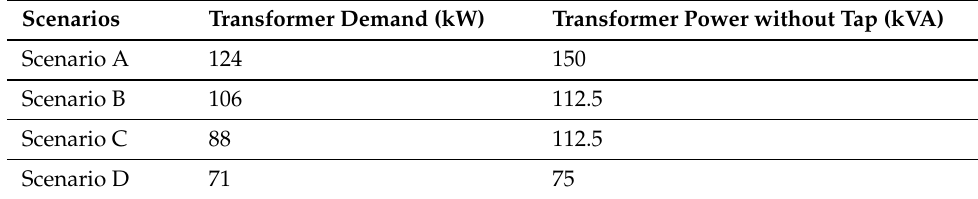
Table 6. Simulation model